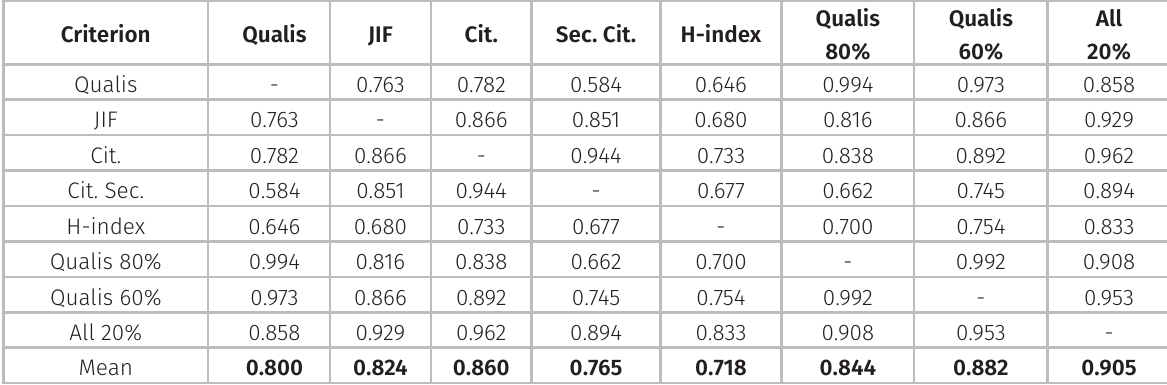
Table VI. Linear correlation between the ranking lists obtained by the 8 classification criteria.